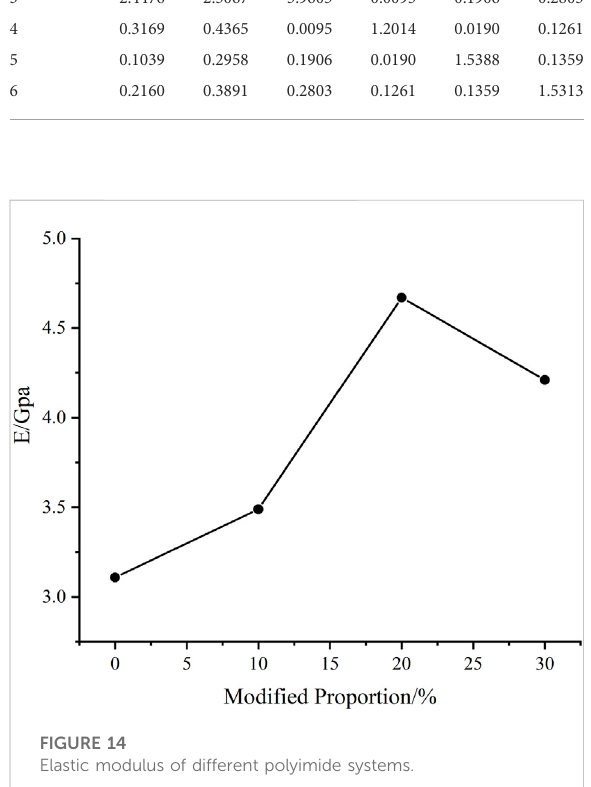
FIGURE 14 Elastic modulus of different polyimide systems.